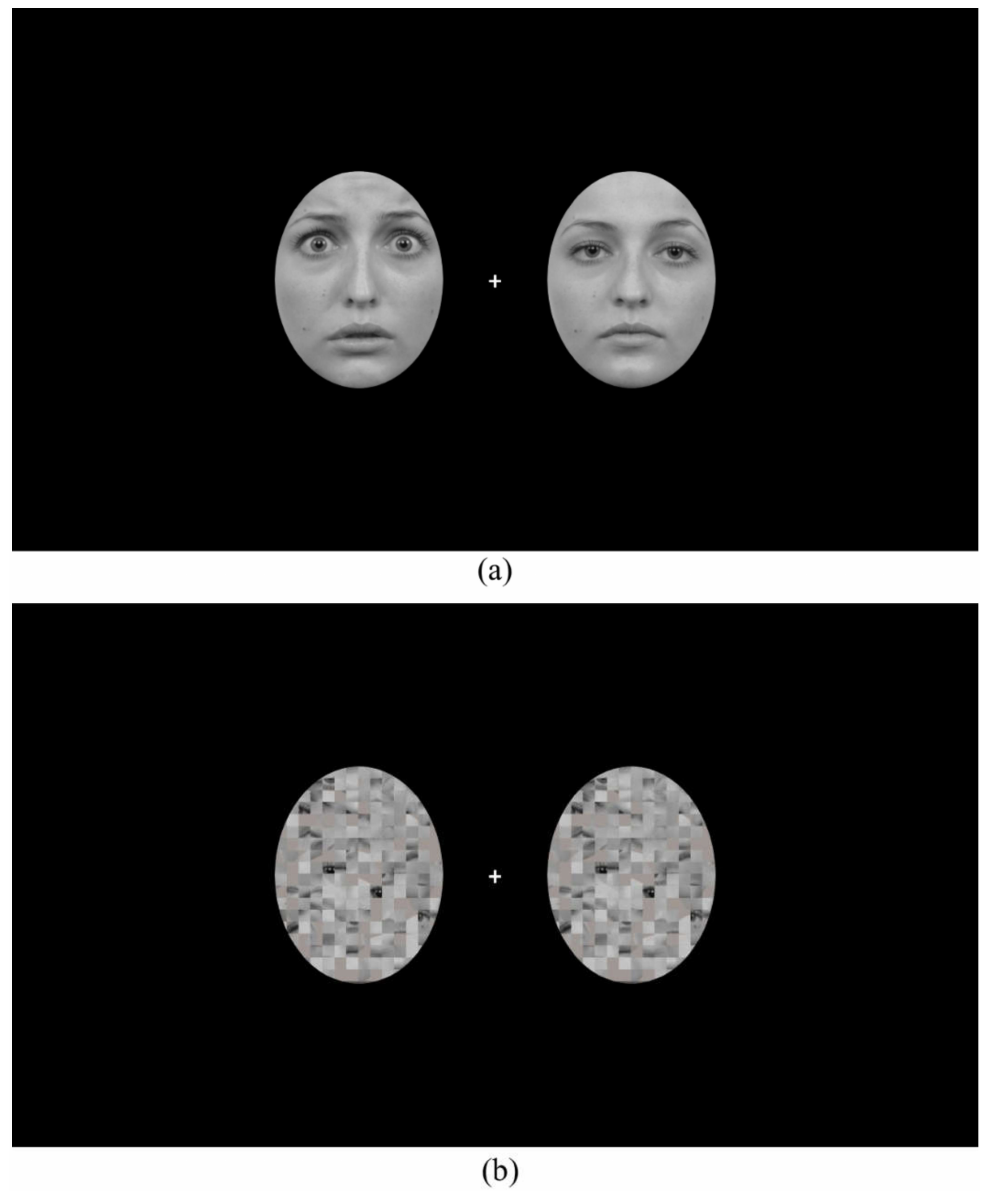
Figure 1. An example of ( a ) the face presentation (fearful face on the left and neutral face on the right ) and an example of ( b ) the mask